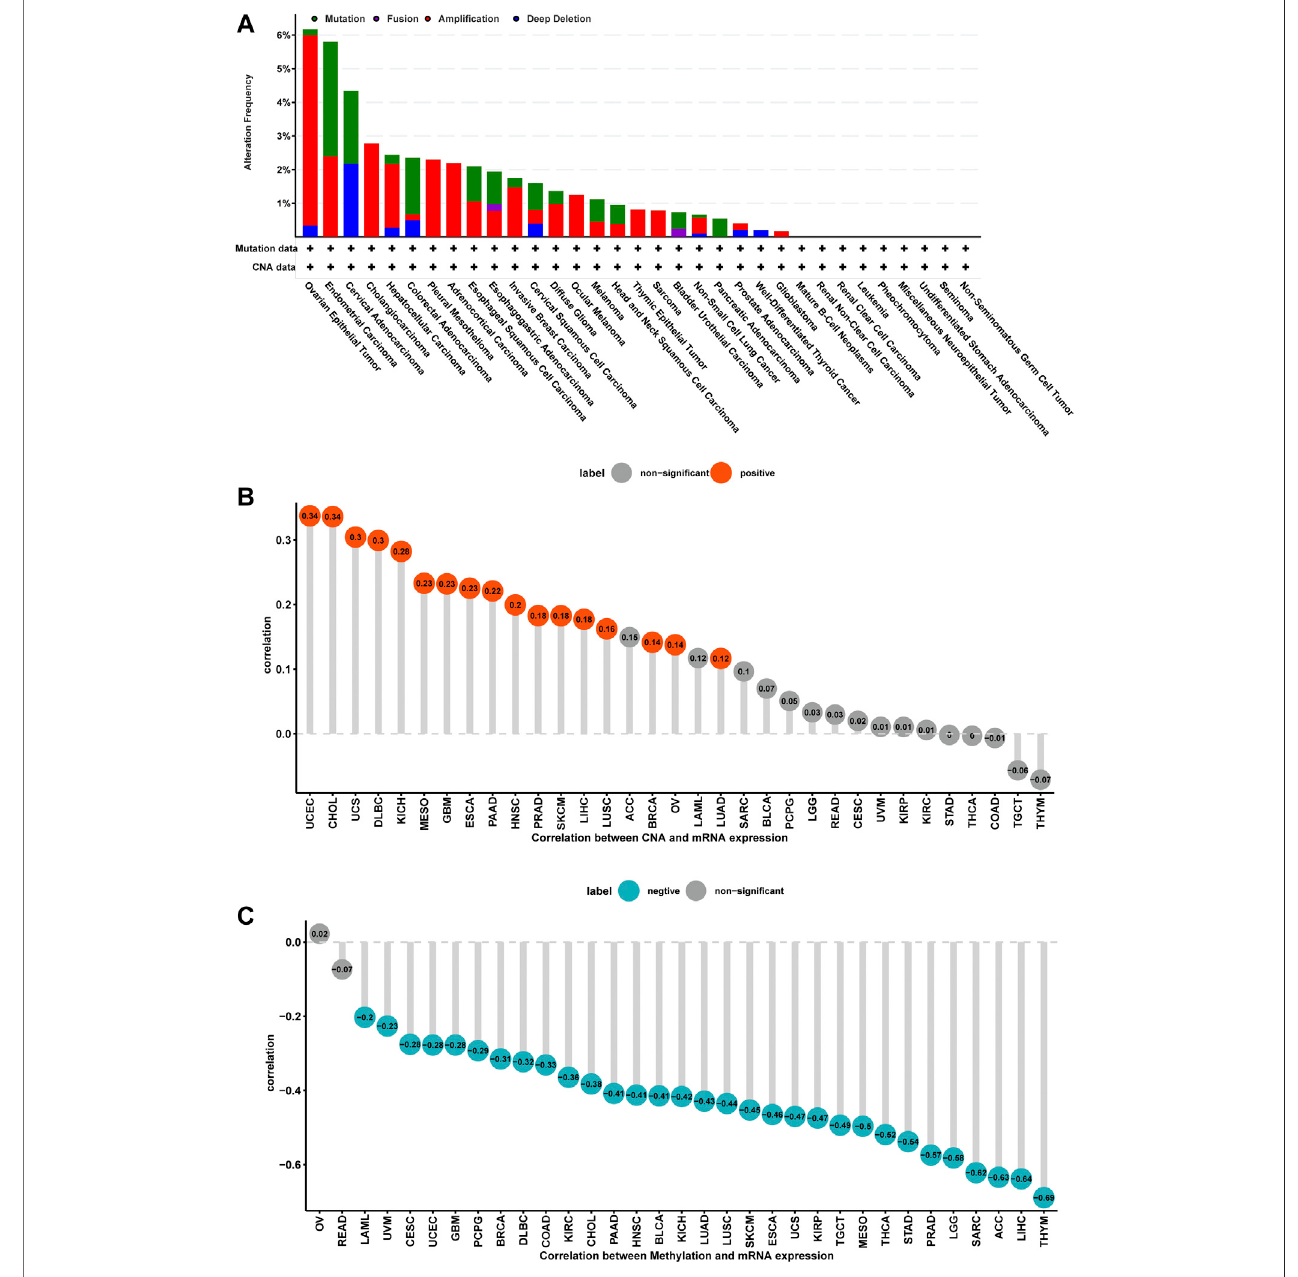
FIGURE 4 | Gene alteration of ISYNA1. (A) The mutation and CNA status of ISYNA1 in TCGA pan-cancer. (B) The correlation between ISYNA1 expression and CNA. (C) The correlation between ISYNA1 expression and DNA methylation.